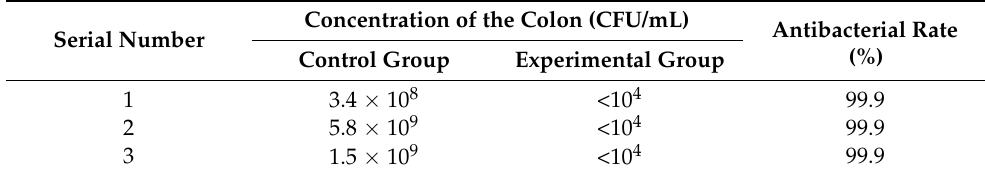
Figure 9. Photographs of agar plates of S. aureus after incubation with PEEK/10 wt% PTFE and PEEK/10 wt% PTFE/0.5 wt% BP. Table 1. A summary of the antibacterial rates of three repeated antibacterial experiments. Serial Number